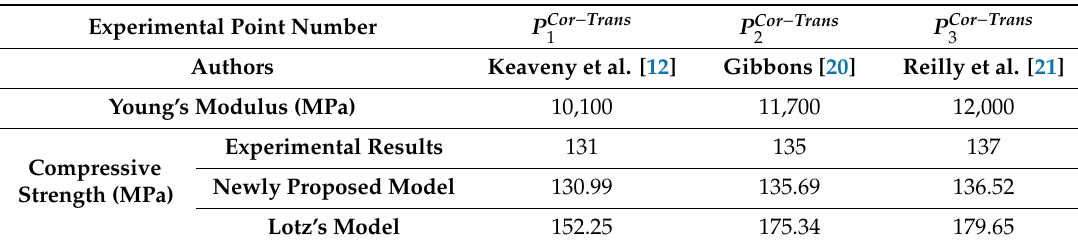
Table 3. A comparison of experimental compressive stress with the newly proposed and Lotz’s models in the transversal